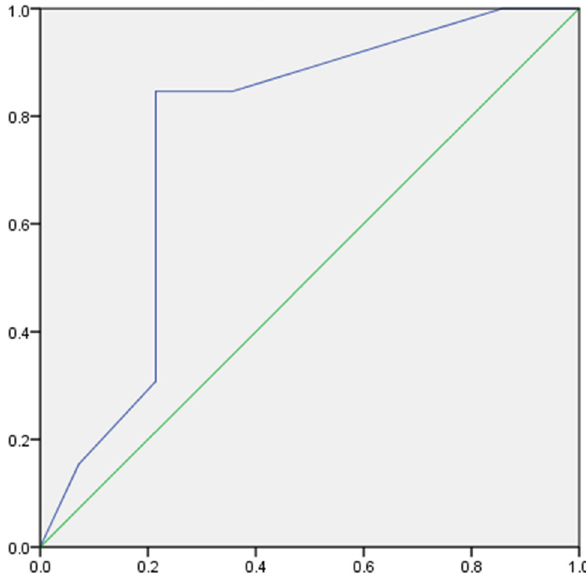
Figure 1. ROC curve for object naming (affected side). Cut off: 8.5/12, sensitivity: 84.6%. Specificity: 78.6%, AUC: 0.764.